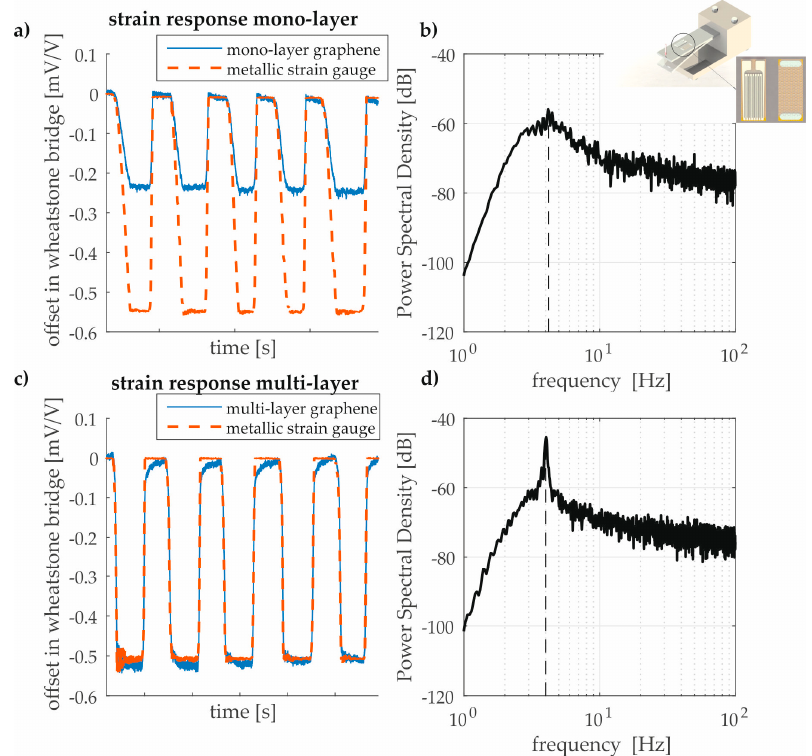
Figure 6. ( a , c ) Electromechanical responses of mono- and multi-layer CVD graphene in comparison to metallic strain gauges for five load cycles; ( b , d ) determination of the first eigenfrequency during load test (using a cut-off frequency filter for frequencies lower than 3 Hz).